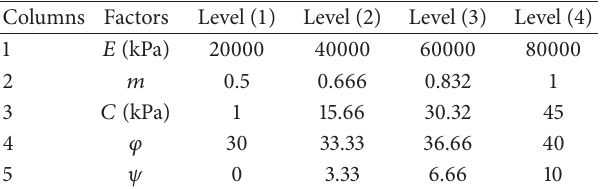
Table 5: Considered levels for each